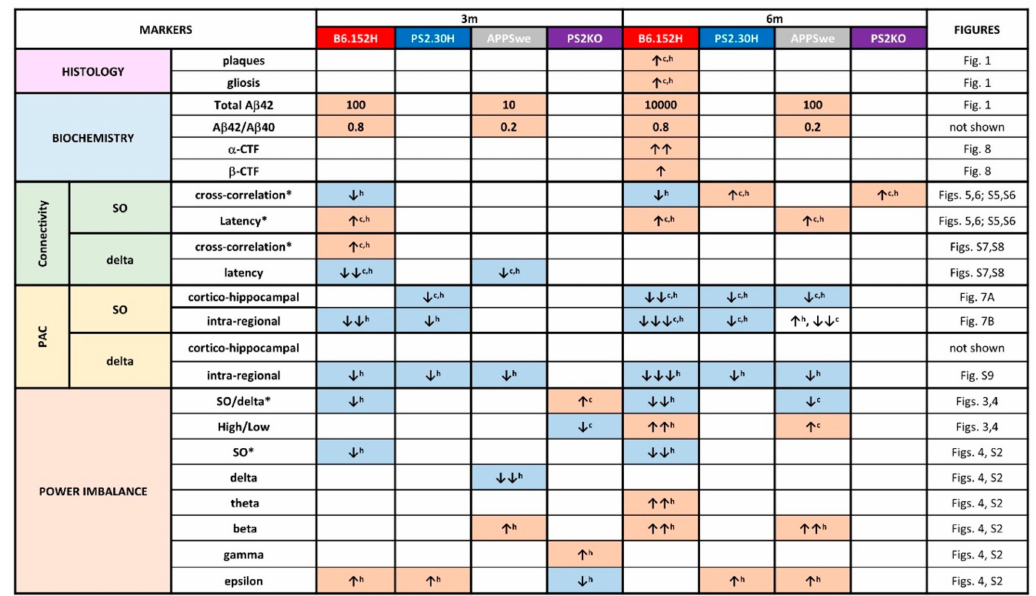
Figure 9. Summary of histological and electrophysiological changes in the di ff erent tg lines. Changes are color-coded as defined in Figure 4; empty boxes indicate no significant changes with respect to age-matched WT mice; c, cortex; h, hippocampus; * parameters changed only in young B6.152H mice. Number of arrows is a rough indication of the entity of change / extension of the region involved, as quantified in the respective figures. For histology and biochemistry, data are also from Refs. 12, 26, 33. Total A β 42 levels are expressed in pg / mg wet tissue and approximated for